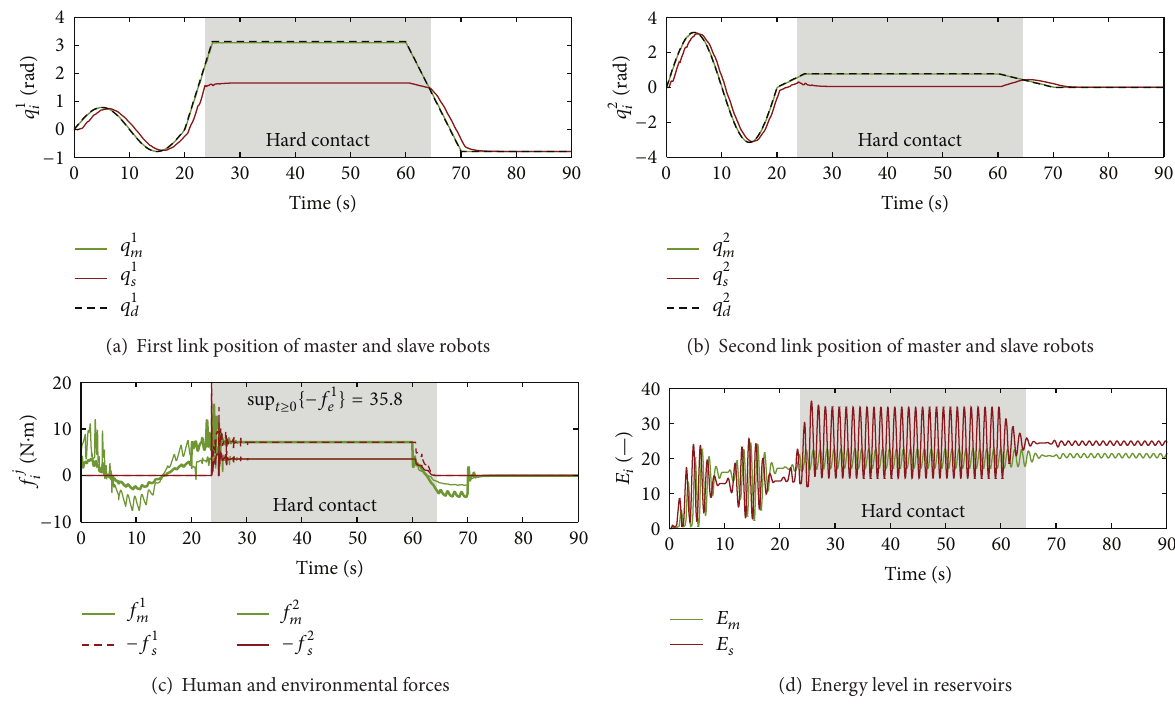
Figure 5: System response for 𝐵 𝑚,𝑠 = 10 [ N ⋅ s ⋅ m ]